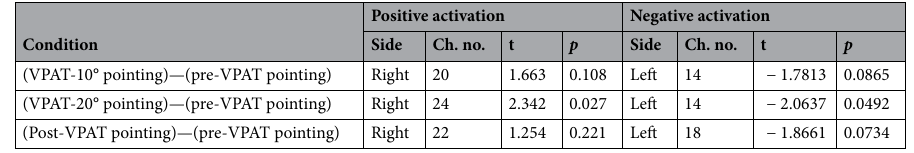
Table 1. Cortical regions most significantly activated during virtual prism adaptation therapy (VPAT).